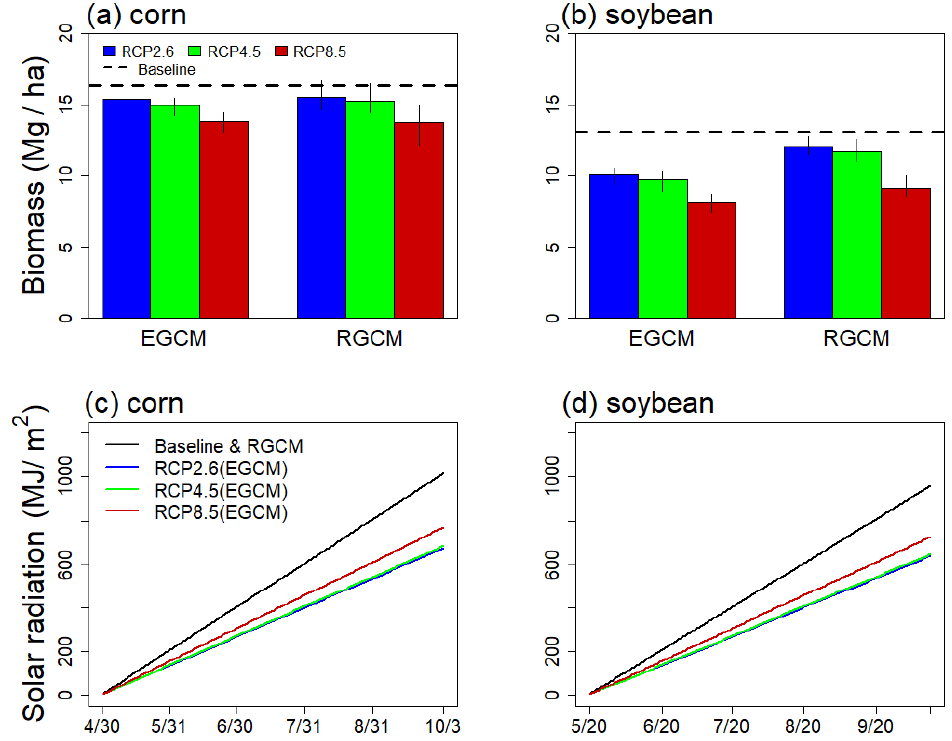
Figure 7. The annual average crop biomass ( a , b ) and daily average of cumulative solar radiation ( c , d